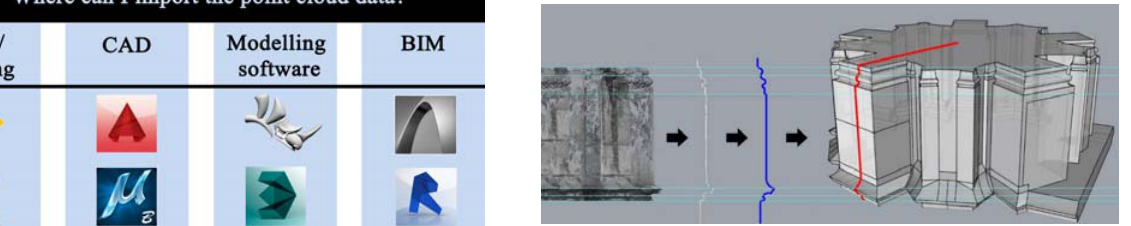
Figure 3. Categories and examples of software that import the point cloud data.